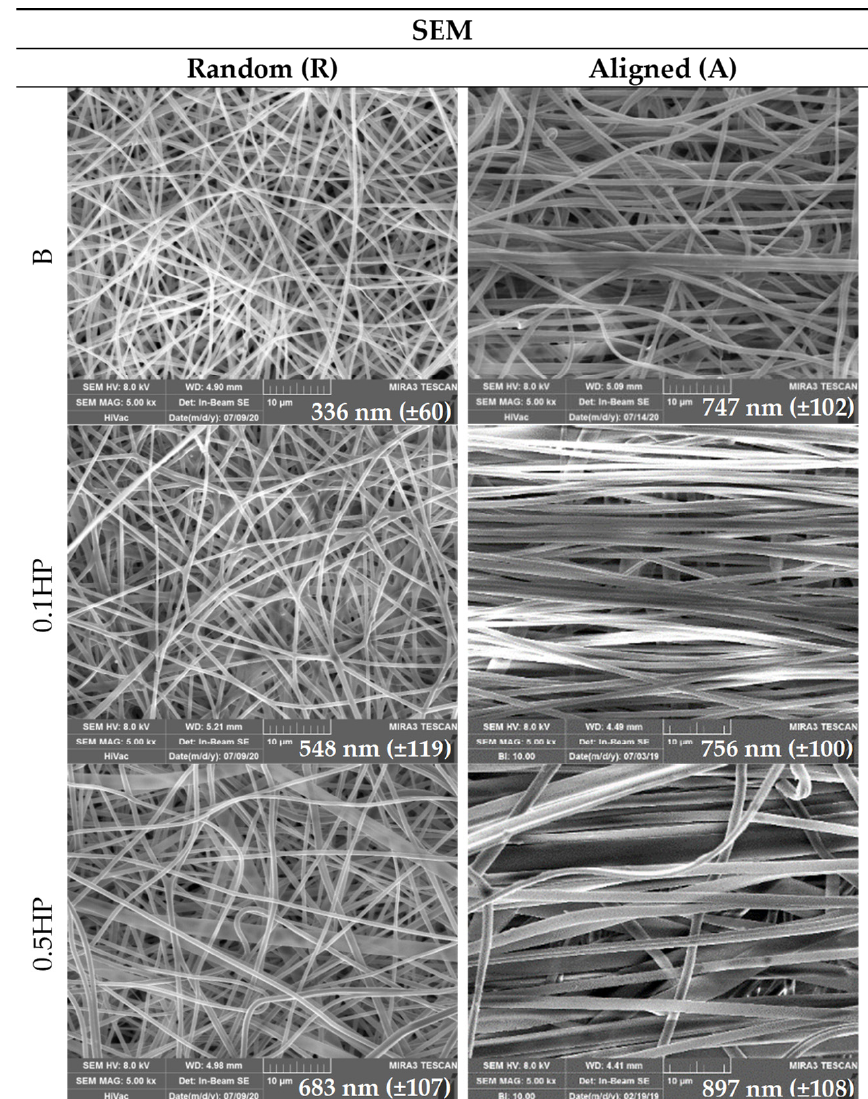
Figure 2. SEM ( left column: random; right column: aligned) microphotographs of scaffolds: Blank; 0.1% HP and 0.5% HP. Scale bar is 10 µ m. In the inset, the mean diameters of nanofibers (nm) are reported. ANOVA one-way; Scheffé test ( p ≤ 0.01): R-B vs. R-0.5 HP, R-0.1 HP, A-B, A-0.1 HP, A-0.5 HP; R-0.1 HP vs. R-0.5 HP, A-B, A-0.1 HP, A-0.5 HP; R-0.5 HP vs. A-0.5 HP; A-B vs. A-0.5 HP; A-0.1 HP vs. A-0.5 HP (mean values ± s.d.; n = 60).